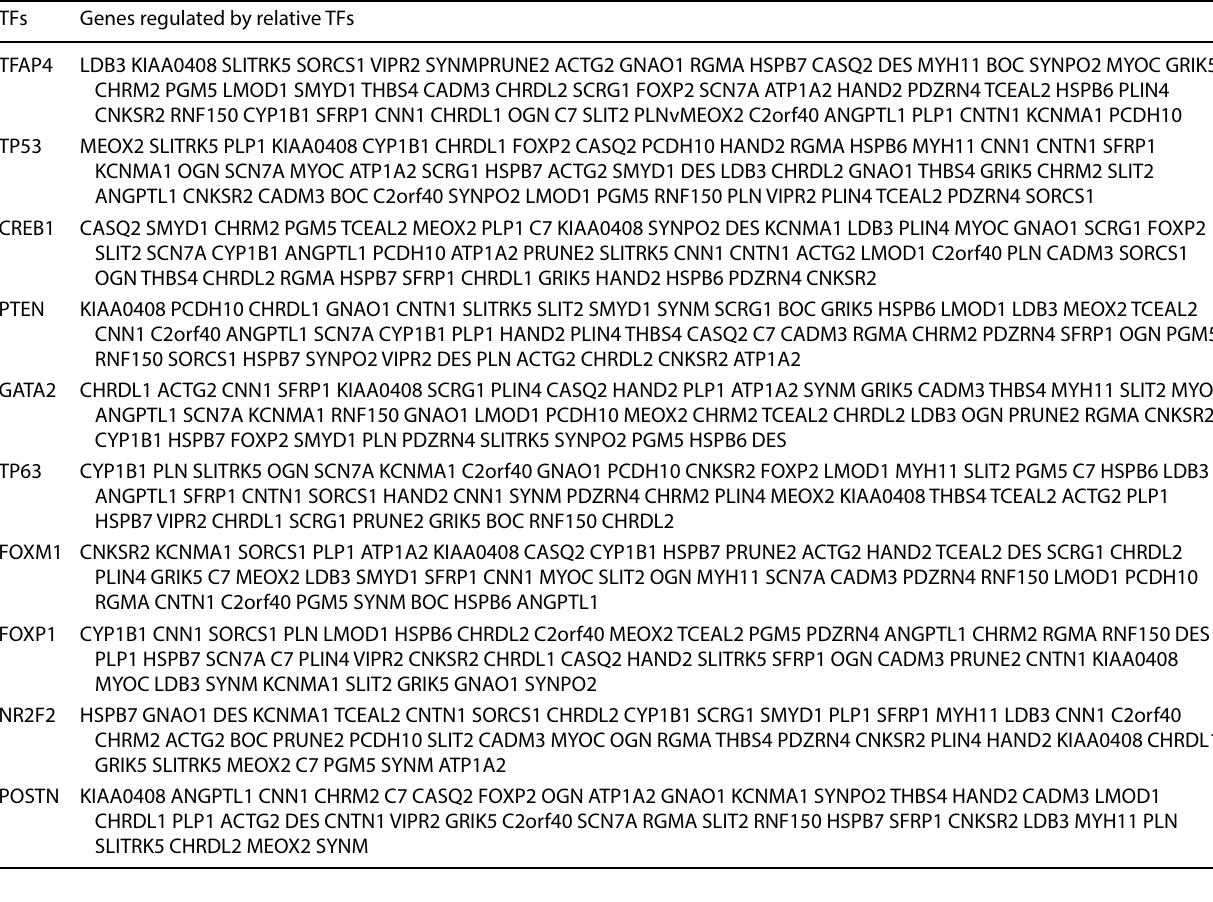
Table 2 Characteristics of the 52 genes that can be transcribed into secreted proteins or enriched in immune